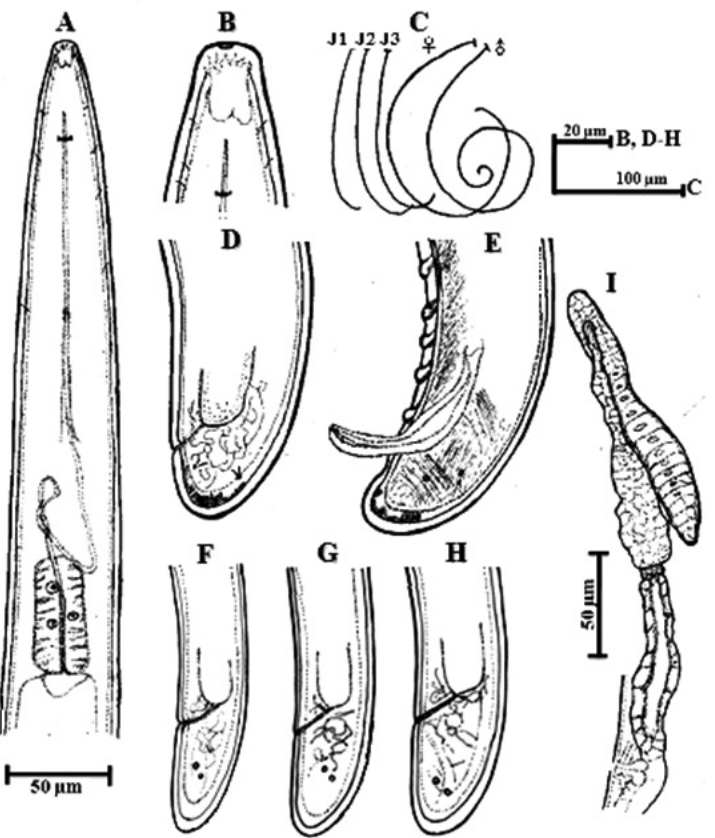
Figure 4. Longidorus cheni sp. n. Female : A Anterior region B Amphidial fovea shape C habitus D Tail region I Anterior genital branch. Male : C Habitus E Tail end. Juveniles : C Habitus F–H Posterior end of first-, second- and third-